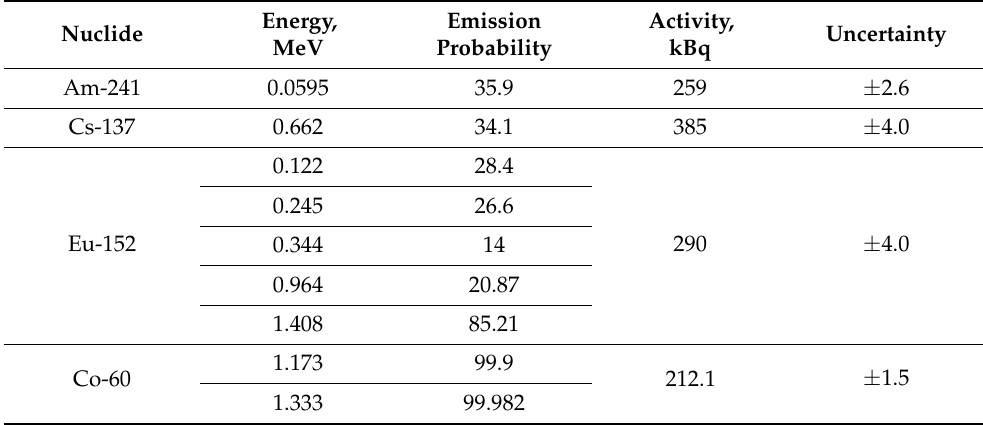
Table 3. The specifications of radioactive point sources used in the present work with